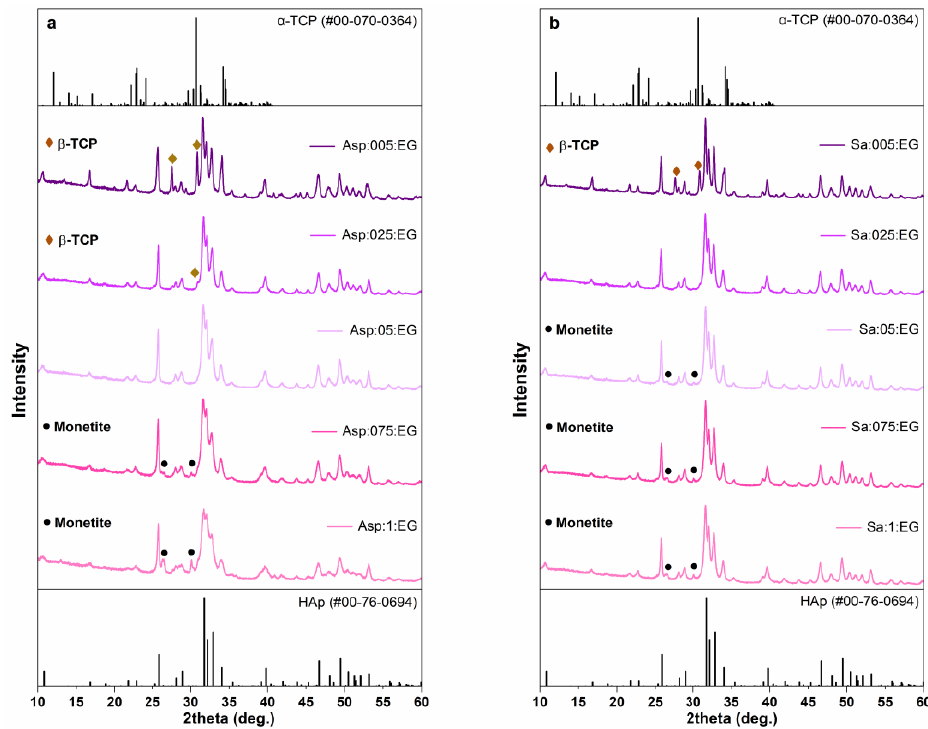
Figure 3. XRD patterns of the samples prepared using various concentrations of DL-aspartic ( a ) and suberic ( b ) acids in water – ethylene glycol mixture (40:60, v/v ) after a solvothermal treatment at 200 °C for 5 h.